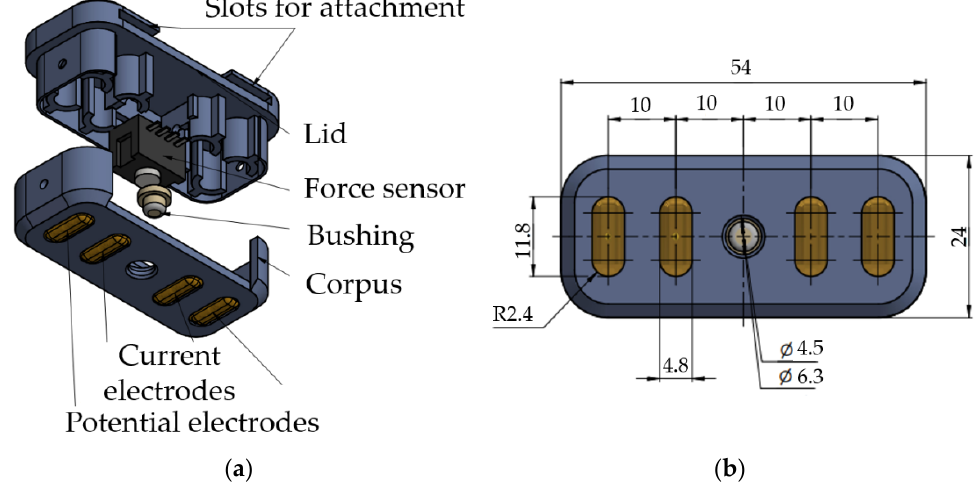
Figure 3. Developed sensor system: ( a ) components of the sensor system; ( b ) dimensions of the sensor system.